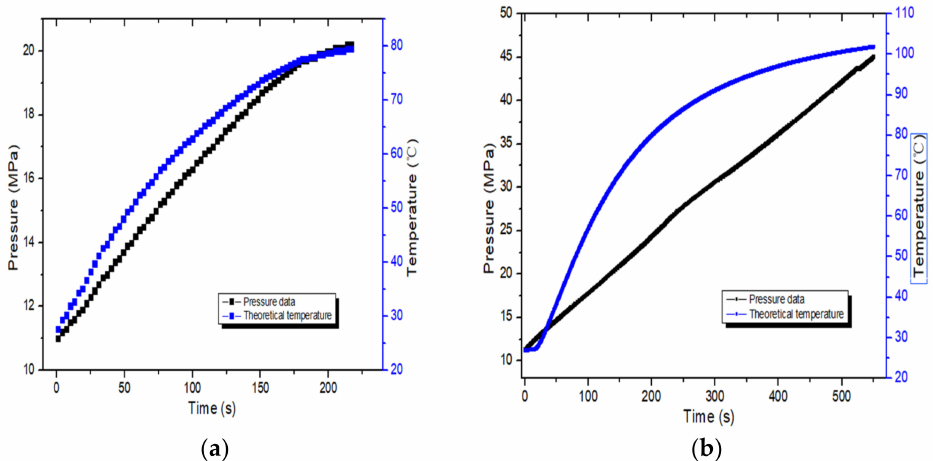
Figure 6. The variations of pressure and theoretical temperature of hydrogen storage tank for the second cycle: ( a ) The pressure change and theoretical temperature of high pressure tank ( b ) The variations of pressure and theoretical temperature of buffer